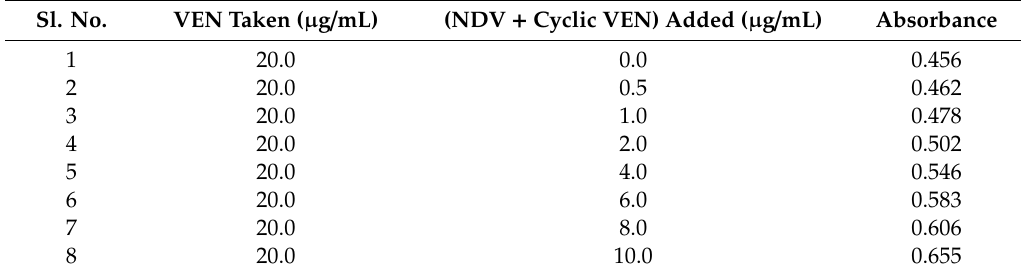
Table 5. Effect of standard addition of mixture of NDV + Cyclic VEN on to VEN samples. Table 5. E ff ect of standard addition of mixture of NDV + Cyclic VEN on to VEN samples. Sl. No. Sl. No.